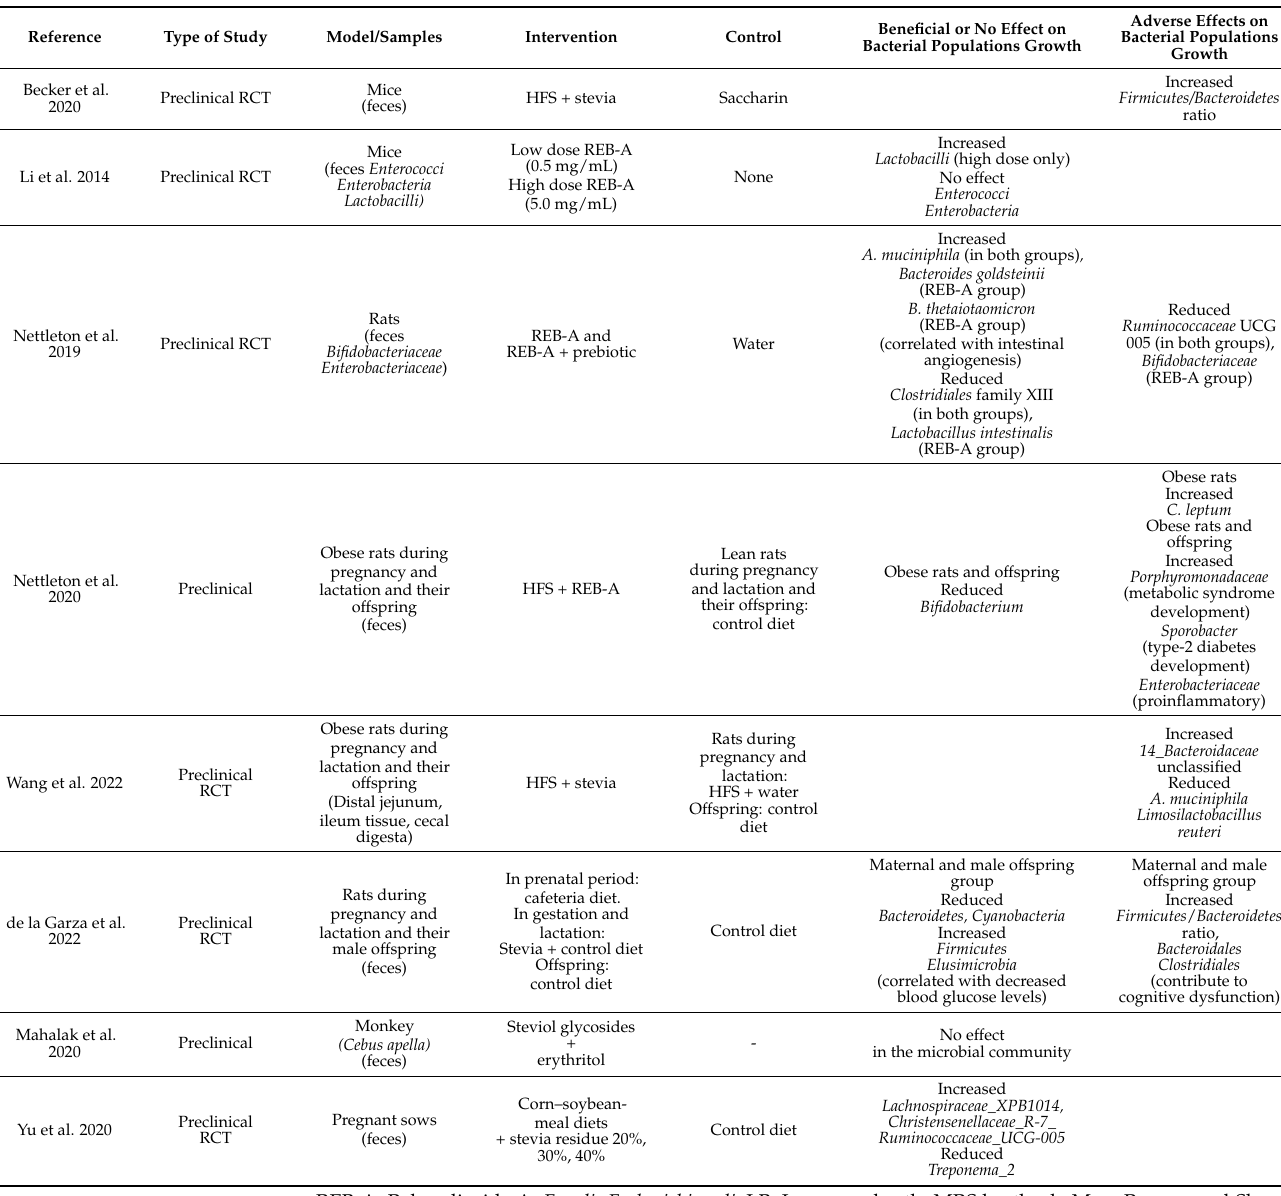
Table 2. In vivo studies presenting the effects of stevia and steviol glycosides on bacterial